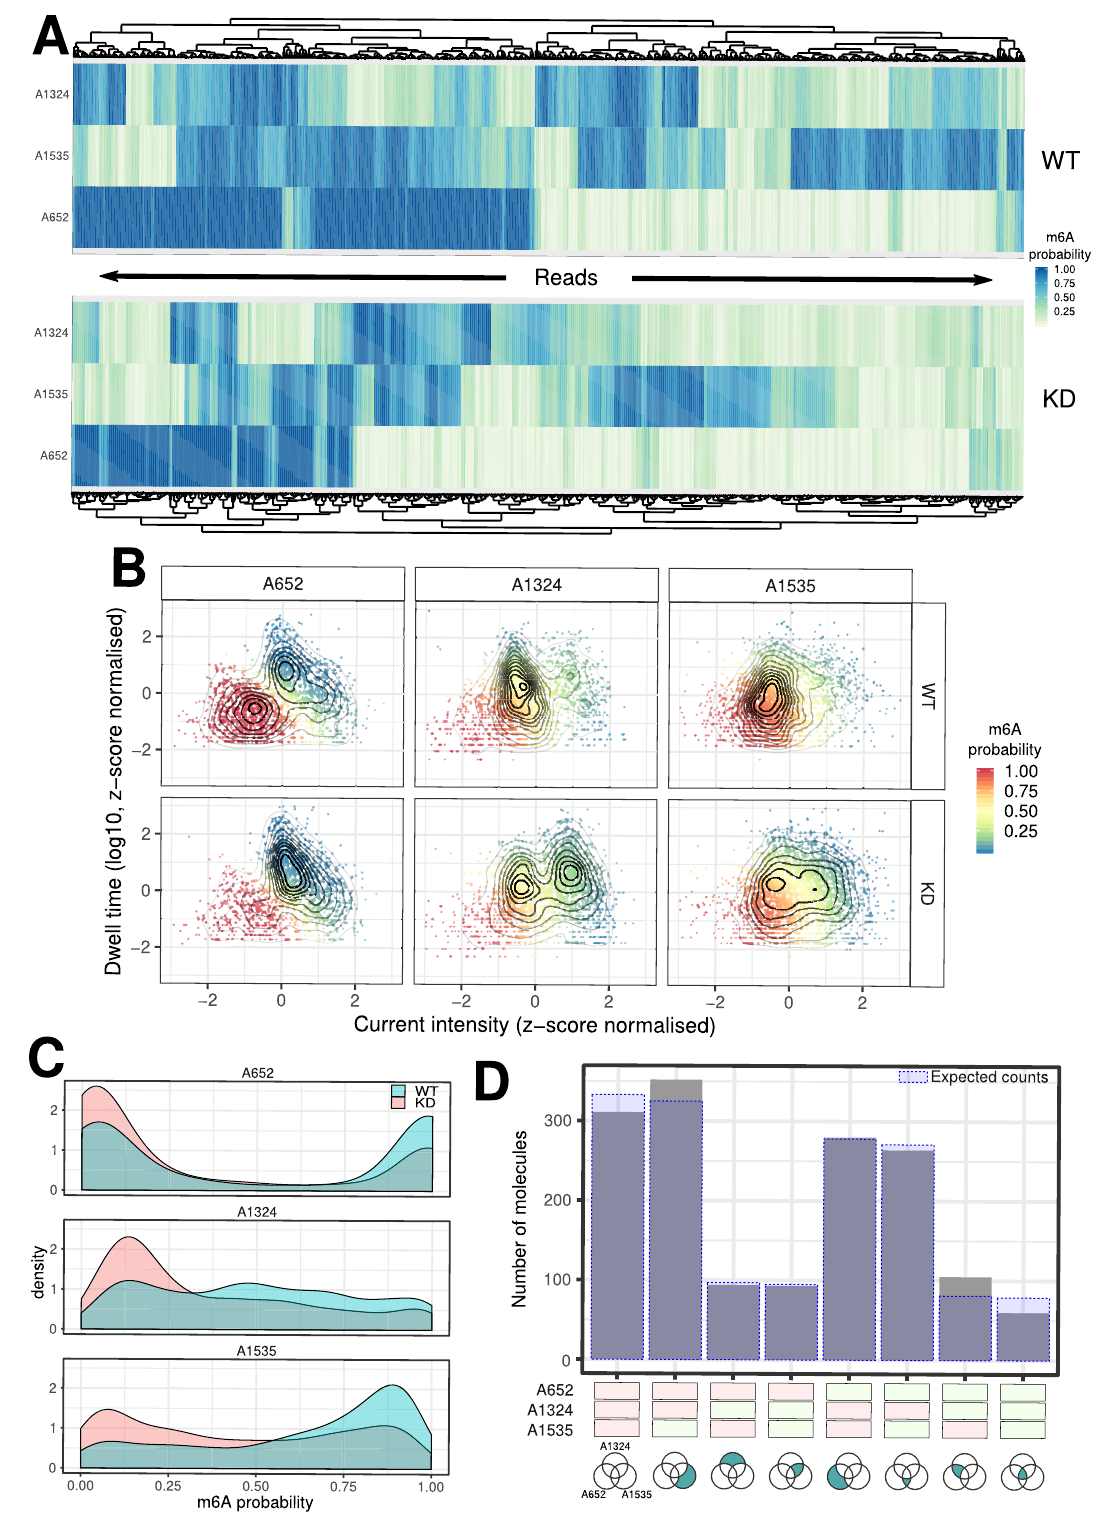
information about modi fi cation stoichiometry and combinatorics. Although Nanocompore currently does not allow measuring stoichiometry, one of its major advantages is the ability to detect RNA modi fi cations at single molecule resolution. As a proof of concept we applied our analysis to the most signi fi cant m6A sites found by Nanocompore in β -actin mRNA and found that mul- tiple methylated residues are present in the same molecule